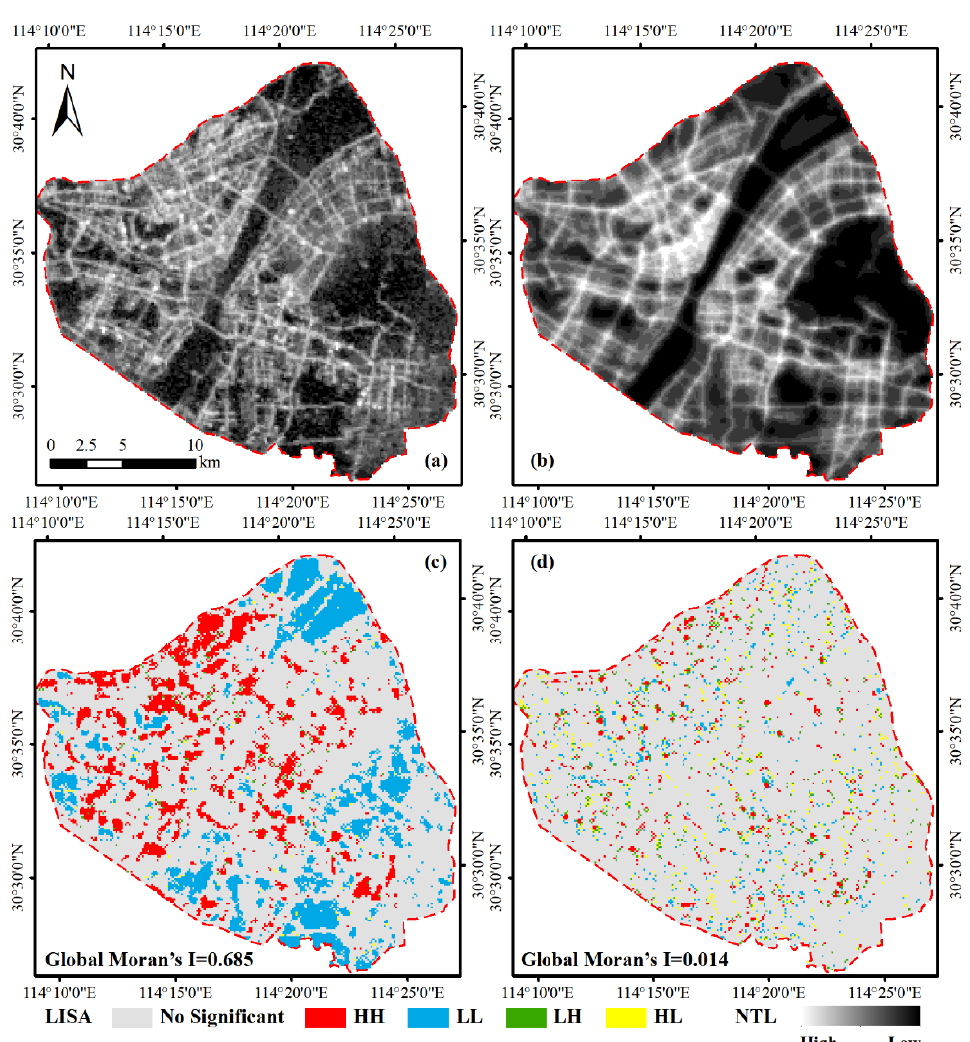
Figure 6. ( a ) NTL intensity observed by Luojia 1-01 image; ( b ) NTL intensity simulated by SDM model; ( c ) local Moran’s I of OLS model regression residual; ( d ) local Moran’s I of SDM model regression residual. HH represents the aggregation of high values and high values. LL represents the aggregation of low values and low values. LH represents low values surrounded by high values. HL represents high values surrounded by low values. No Significant represents the residuals’ approximately random distribution.